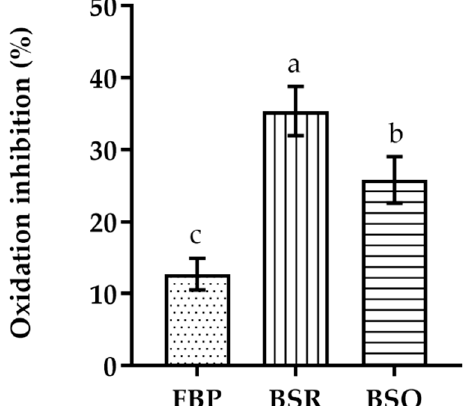
Figure 1. Linoleic acid/ β -carotene bleaching inhibitory activity of extracts of different parts of C. album berries. FBP, fresh berries pulp (dotted); BSR, berries seed residue (vertical bar); BSO, berries seed oil (horizontal bar). Values represent the mean ± standard deviation of three independent experiments obtained after 2 h of reaction and for the highest concentration of each extract. Bars with different lowercase letters (a–c) indicate significant differences (Tukey’s post hoc test, p < 0.05).